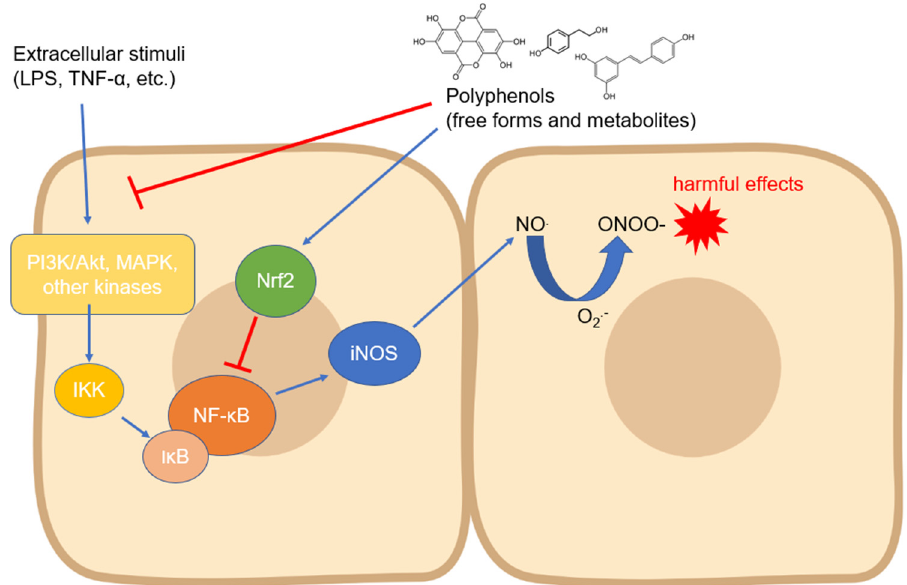
Figure 2. Modulation of iNOS expression by polyphenols involving the downregulation of up- stream kinases and NF- κ B. Abbreviations: IKK—I ĸ B kinase; iNOS—inducible nitric oxide